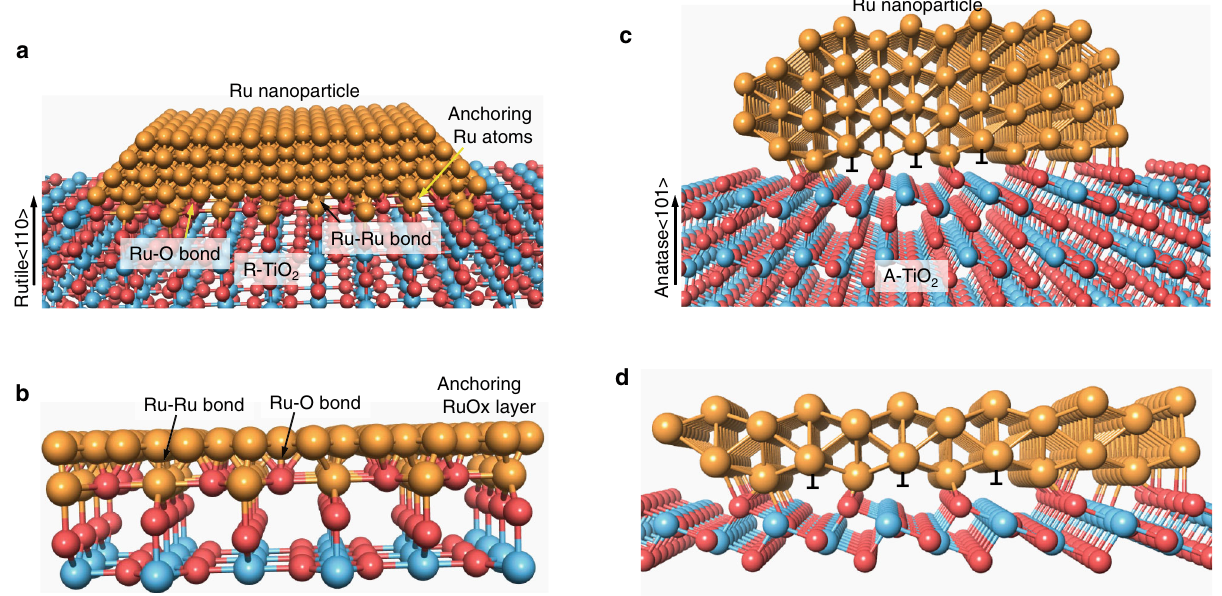
Fig. 6 Atomic schemes showing the effects of interfacial compatibility on Ru/TiO 2 adhesion strengths. a Scheme of epitaxial dispersion of Ru nanoparticle on rutile TiO 2 (110) surface. b Interfacial Ru – O and Ru – Ru bonds in anchoring RuO x layer on R – TiO 2 . c Scheme of Ru nanoparticle on anatase TiO 2 (101) surface. d Scheme of interfacial of bonds and defects of Ru with A – TiO 2